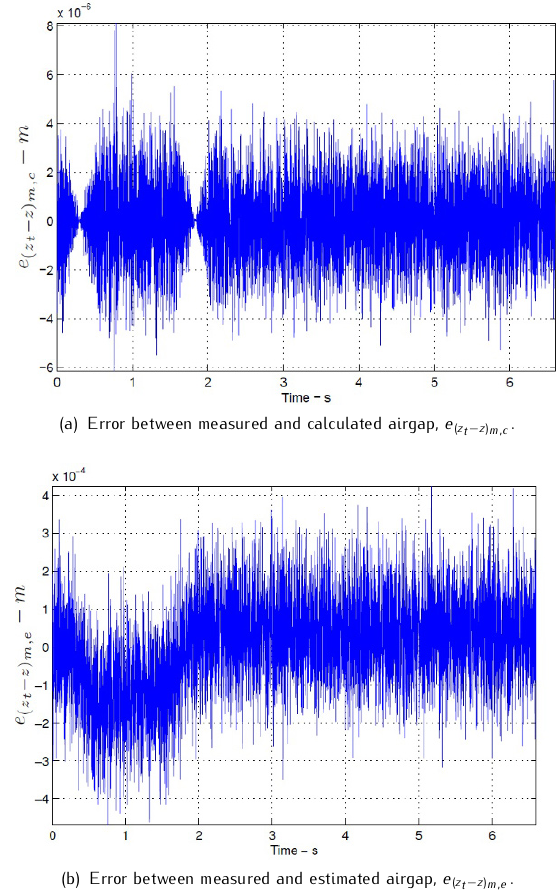
( e ( z t −z ) m,e ), Figure: 10(a): the measured and calculated ( e ( z t −z ) m,c ) and Figure 10(c): the estimated and